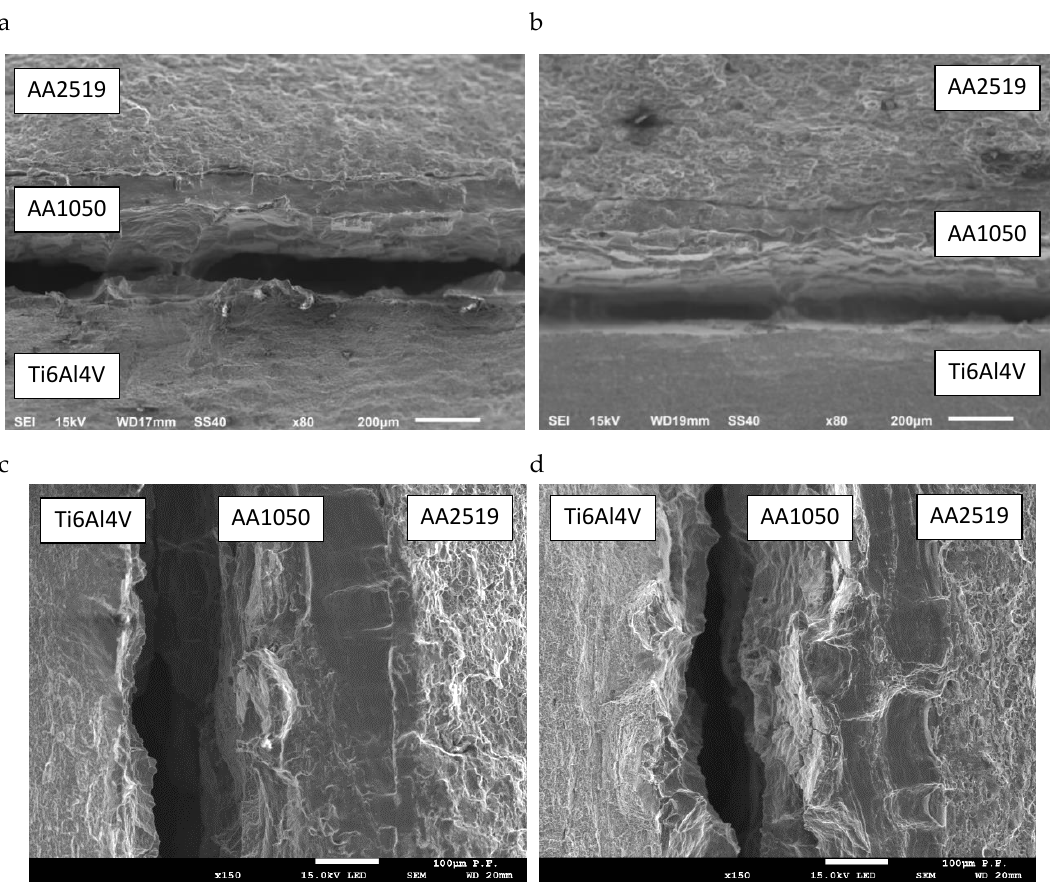
Figure 9. Delamination cracking in specimens tested at a different temperature: ( a ) CT-293 K, ( b ) CT-77 K, ( c ) SENB-293 K, and ( d ) SENB-223 K.